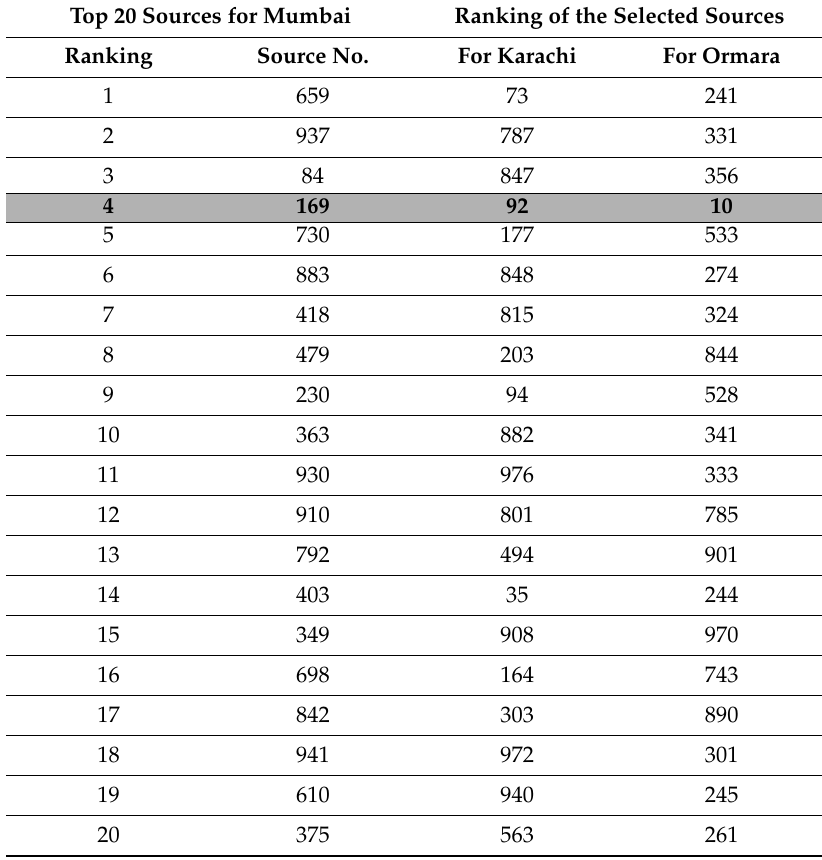
Table 1. Top 20 best matching sources for Mumbai and their ranking values for Karachi and Ormara. Top 20 Sources for Mumbai Ranking of the Selected Sources Ranking Source No. For Karachi For Ormara 1 659